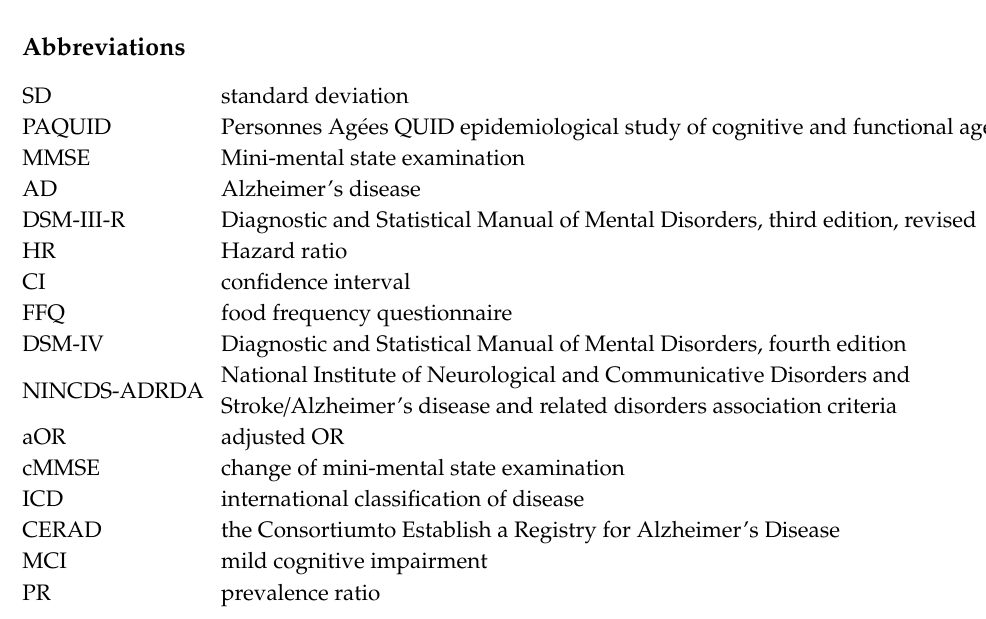
Figure S1: Contour-enhanced funnel plot assessing publication bias reporting meat intake levels in cases with cognitive disorders compared to in controls, Figure S2: Contour-enhanced funnel plot assessing publication bias reporting odds ratios (ORs) of meat consumed weekly or more vs. less frequently in cases with cognitive disorders compared to in controls, Table S1: Reporting checklist of meta-analyses of observational studies in epidemiology (MOOSE), Table S2: Searching terms and strategies, Table S3: Quality assessment scale for observational and intervention studies with detailed guidance, Table S4: Quality assessment results of studies